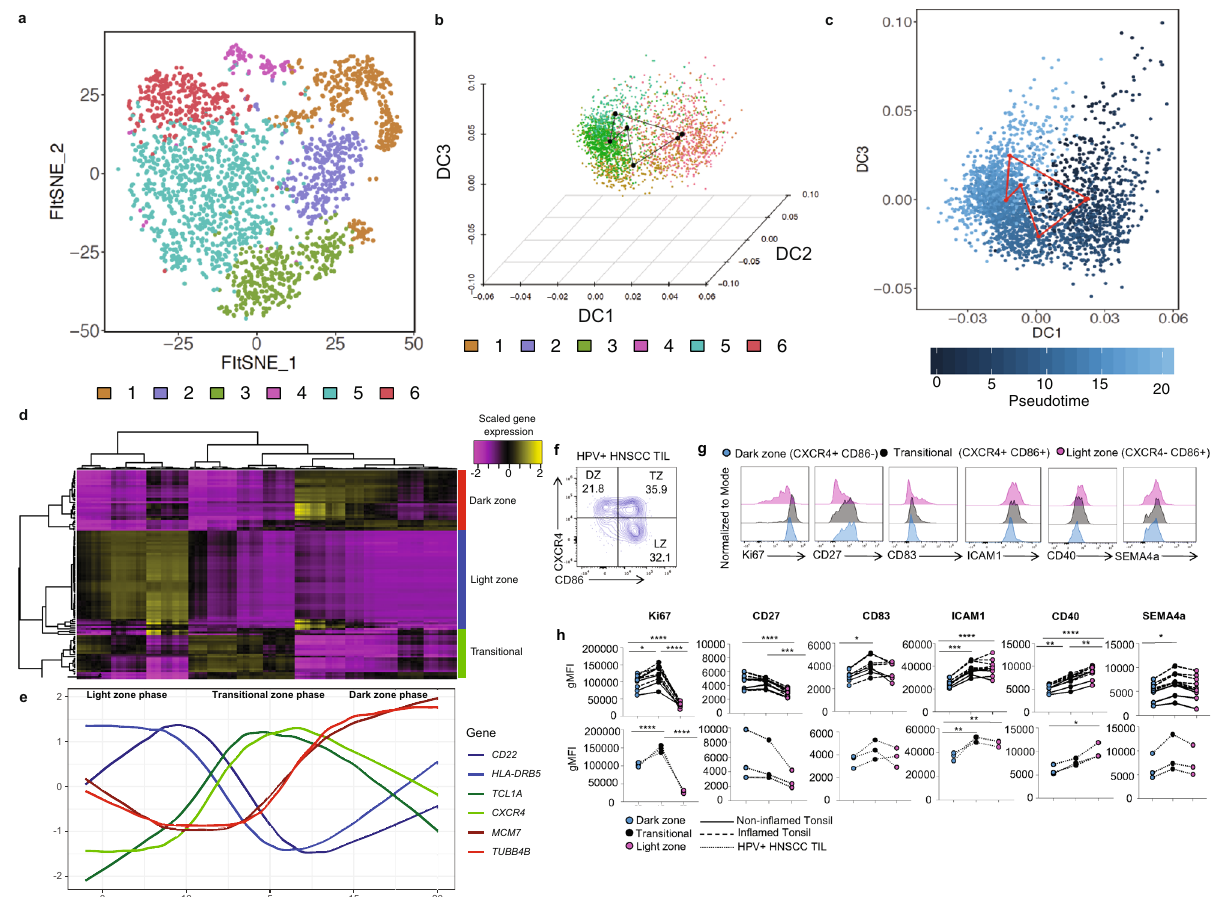
Fig. 5 Cyclical pseudotime modeling of germinal center B cell reactions reveals waves of gene expression. a FItSNE showing 6 clusters of germinal center B cells (i.e. cells from clusters 17 and 18 from Fig. 1A/D). b Three-dimensional diffusion map embedding of germinal center B cells, with cells colored by their cluster identities from a . Black dots represent the centroid of each cluster, and the lines connecting the black dots represent the circular path through germinal center reactions. c DCs 1 and 3 captured most of the information required to reconstruct the circular trajectory of germinal center B cells (left panel). Pseudotemporal ordering was inferred by fi tting the equivalent of a non-parametric principal component from the center of the trajectory using the assumption that the data is on a closed curve (right panel). d Loess regression was used to fi t curves for the top 20 differentially expressed genes across GC B cell clusters as a function of pseudotime inferred in c . Genes were found to cluster into three distinct groups by fi t with pseudotime. Clusters were de fi ned as dark zone, light zone, and transitional. Analysis in a – d is derived from six healthy blood donors, fi ve tonsils, and 27 HNSCC patients. e Marker genes derived from d , with scaled gene expression plotted as a function of time. Blue genes correspond to light zone (LZ) GC B cells, green genes correspond to B cells moving between LZ and dark zone (DZ) GC B cells, and red genes correspond to DZ GC B cells. f Representative fl ow plot showing gating strategy for LZ, DZ, and TZ populations. CD38 + IgD − BCL6 + (GC B cells) were then gated on CXCR4 and CD86. Dark zone (DZ) CXCR4 + CD86 − , “ Transitional ” (TZ) (CXCR4 + CD86 + ) and Light zone (LZ) (CXCR4 − CD86 + ) were identi fi ed. g Representative plots comparing expression of the three distinct GC TIL-B populations, DZ (blue- fi lled histogram), TZ (black- fi lled histogram) LZ (pink- fi lled histogram) h Scatter plots quantifying differences in geometric mean fl uorescence intensity of indicated key markers on the three distinct GC B cell populations in tonsils and HPV + HNSCC. Statistical analysis by ordinary one-way ANOVA followed by Tukey ’ s multiple comparisons test. * P = 0.02, ** P = 0.002, *** P = 0.0002, **** P = < 0.0001. Source data are provided as a Source Data fi